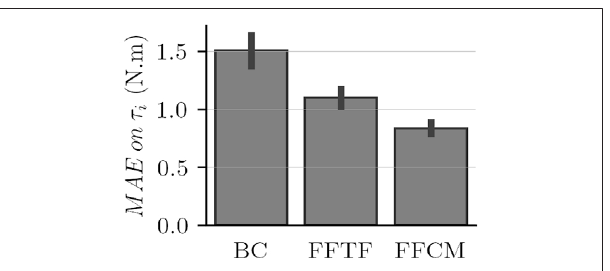
FIGURE8| Comparison ofthetrackingperformanceeach controllaw in terms of MAE on τ i for each experimental